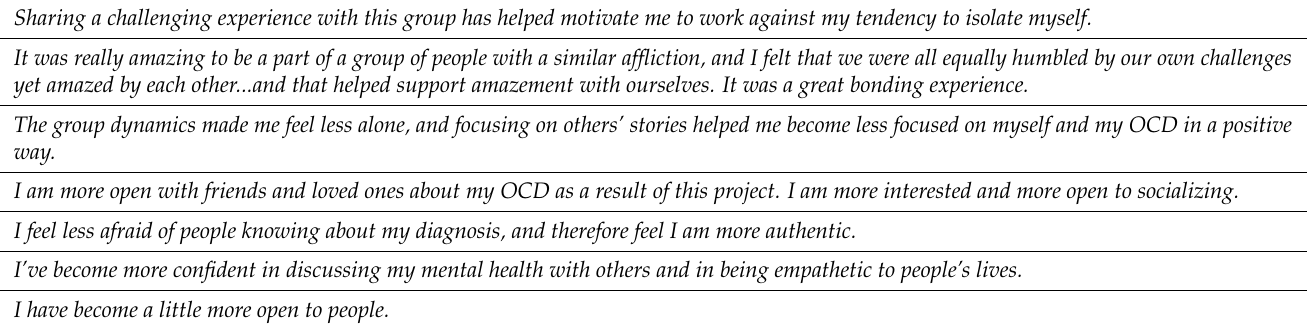
Table 4. Participant open-ended survey responses.